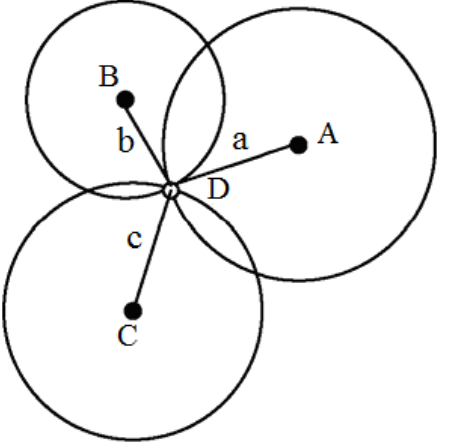
Figure 2 . Principle of the centroid algorithm.